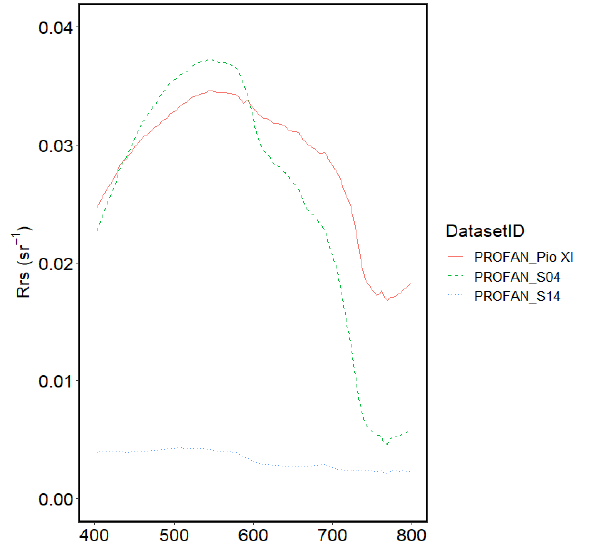
Figure 7. Remote sensing reflectance (Rrs) of 3 stations at different distances from glaciers as function of wavelength (nm) collected during the PROFAN campaign in November